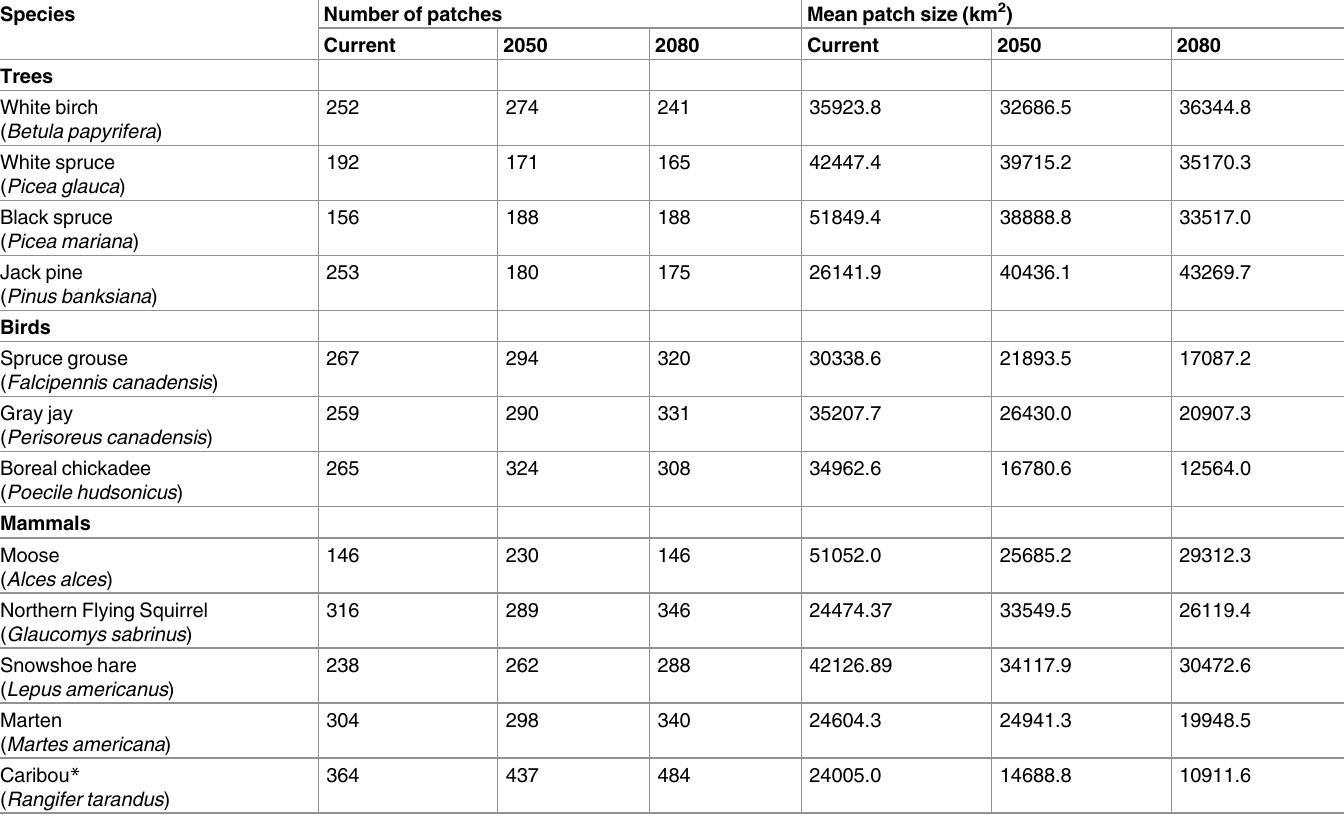
Table 2. Number of suitable patches and mean patch size for boreal forest species under current and future climate projections (2050, 2080), within the full current range of each